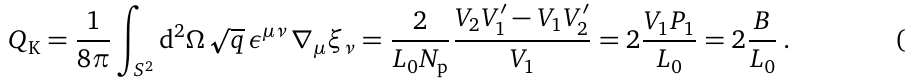
Figure 1: Plot of the classical trajectories in configuration space ( log V singularity is located at V fiducial length scale is set to L